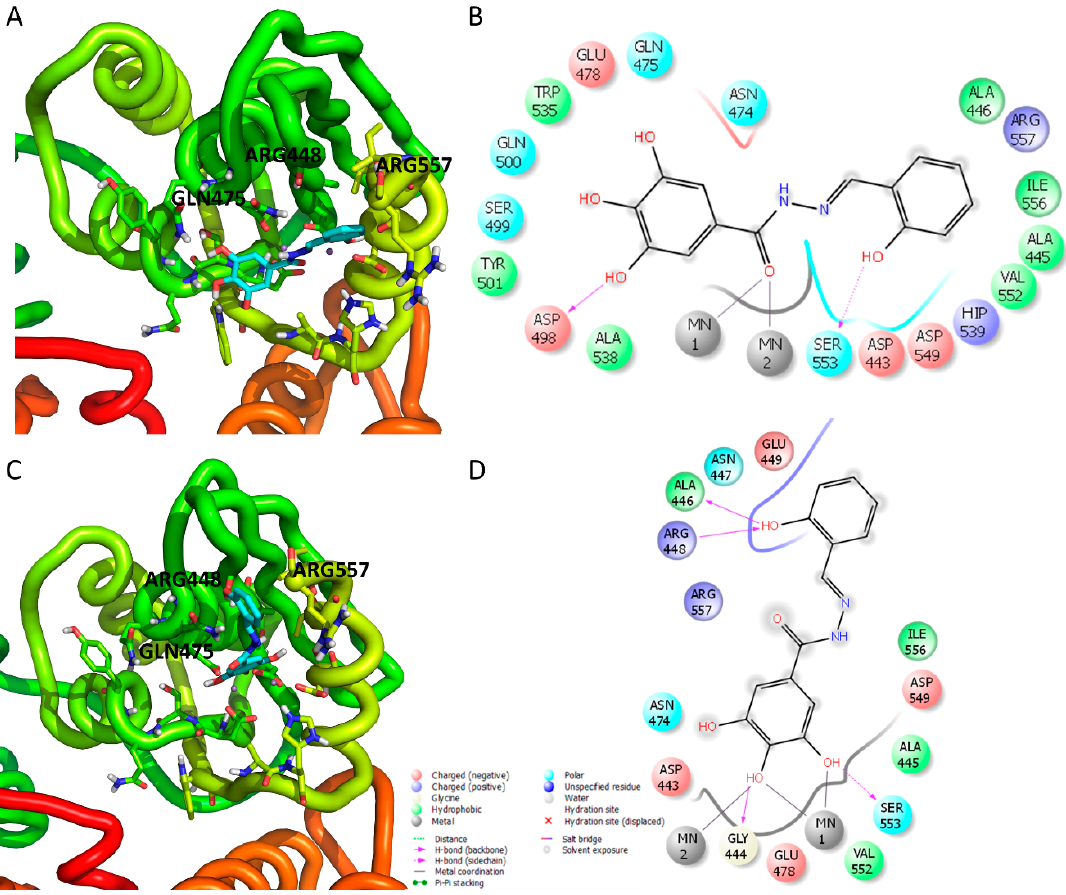
Figure 3. Putative binding mode of compound 13 within the HIV-1 RT RNase H domain. ( A – C ) Compound 13 in cyan depicted in the wt-RT: p66 in green, p51 in orange; ( B – D ) 2D representation of compound 13 in complex with wt RT with indication of binding pocket interacting residues.